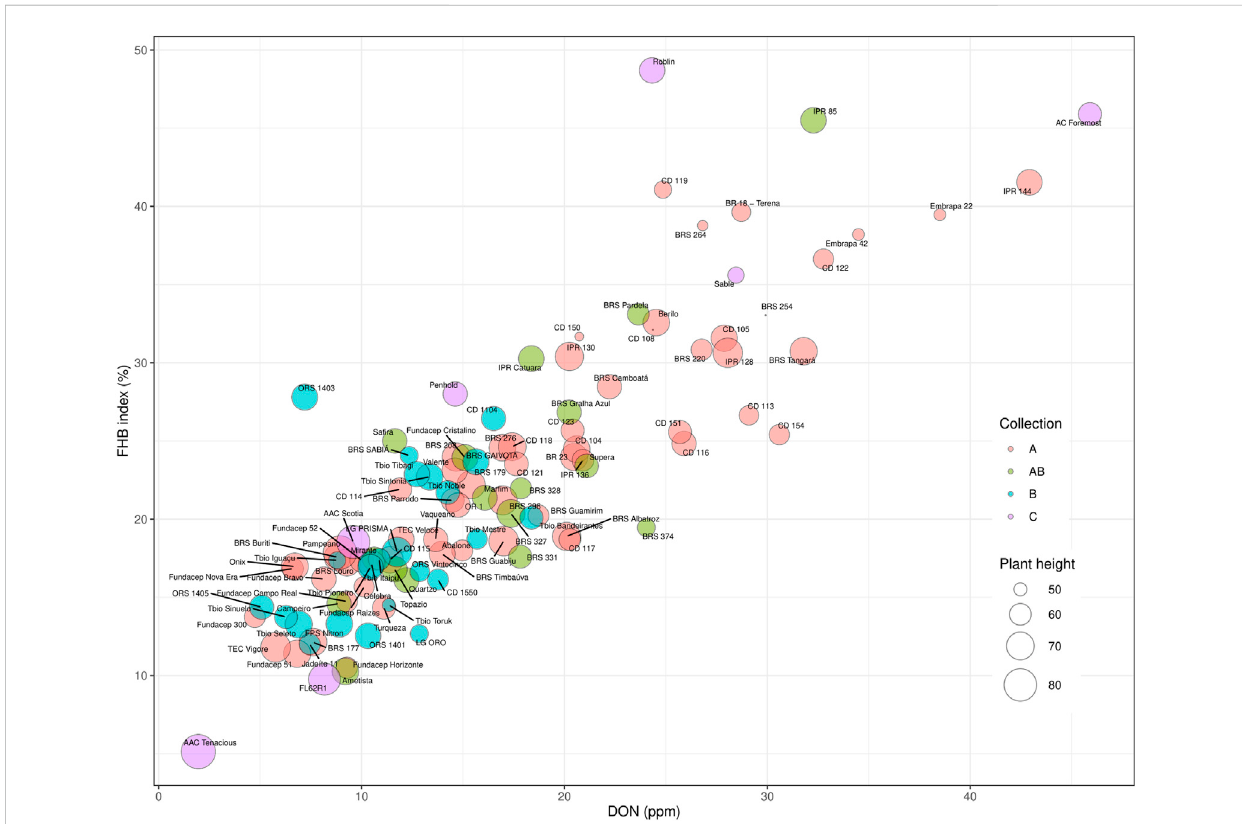
FIGURE 5 Each analysed cultivar plotted in a bubble plot with FHB index as y-axis, DON accumulation at x-axis and plant height — size of the bubble. The cultivars were classi fi ed by the collections, which created a fourth dimension (color) in the plot: “ A ” red, “ B ” blue, “ AB ” green, “ C ” purple, which refers to Canadian